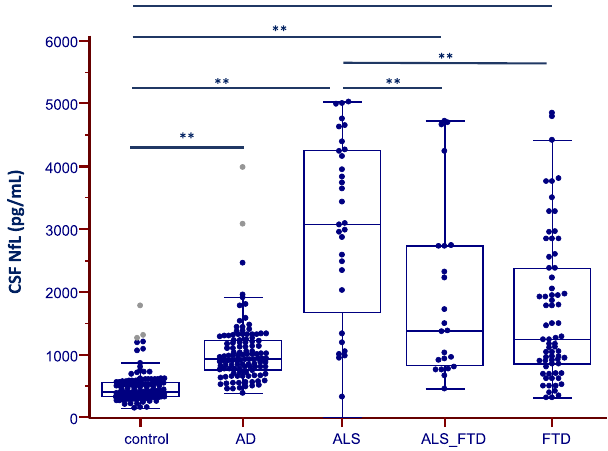
Figure 2. CSF Neurofilament light (NfL) protein levels in patients within the FTD-ALS spectrum. Box and whisker plots of the median concentrations of CSF NfL in control participants and patients with dementia: Alzheimer Disease (AD) and Amyotrophic Lateral Sclerosis associated or not with FTD (ALS-FTD and ALS, respectively) and Frontotemporal Dementia (FTD). The central black lines show the median values, regions above and below these lines show the upper and lower quartiles, respectively. Outliers (indicated with grey circles) are defined as a value that is larger than the upper quartile plus three times the interquartile range. ** p = 0.005.